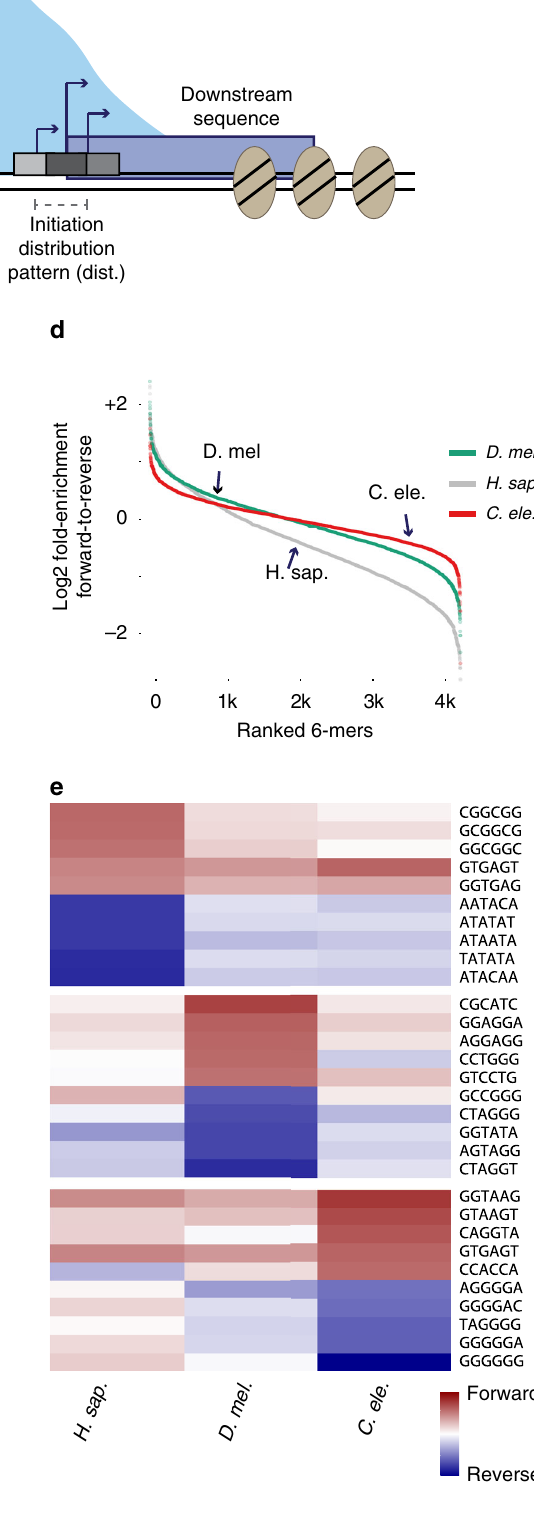
effective transcription elongation in the forward and reverse direction 7,8 . To compare these asymmetries across organisms, we adopted the approach taken by Almada et al. 7 and contrasted the ratio of forward-to reverse six-mer occurrences across 500 bp windows downstream of forward or reverse TSSs (Fig. 2a, d). NATURE COMMUNICATIONS| (2018) 9:4472 |DOI: